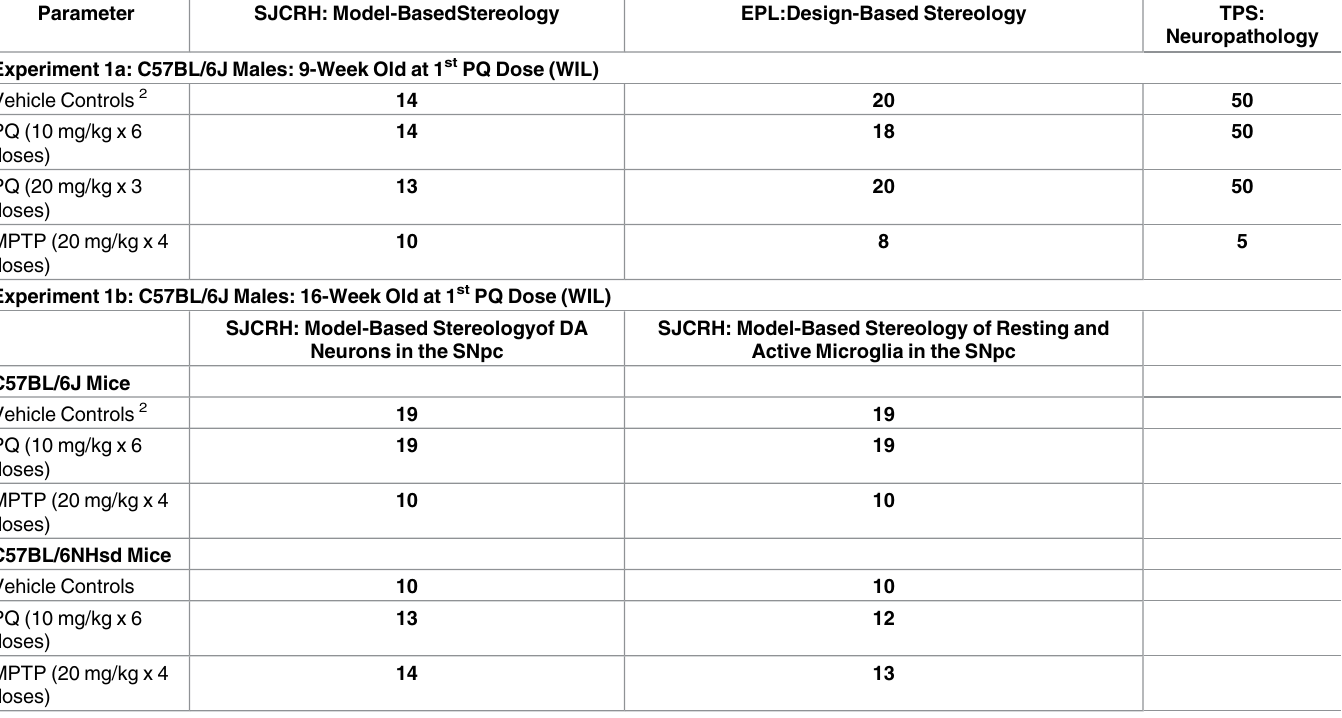
Table 1. Number, design and location of studies examining effects of paraquat and MPTP on C57BL/6J and C57BL/6NHsd male mice (aged 9 or 16 weeks) 1 .